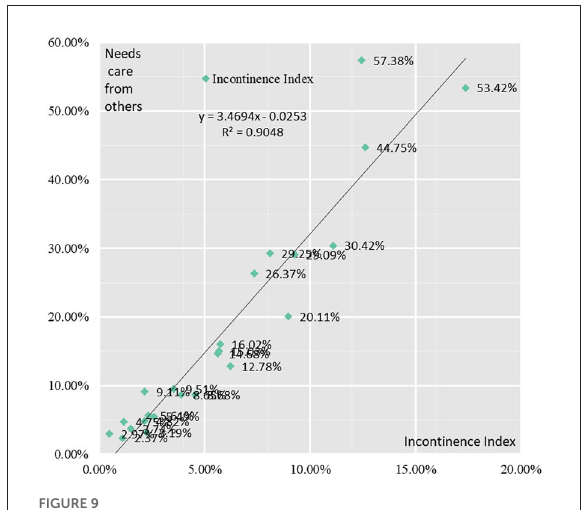
FIGURE9 Correlation analysis between healthcare needs of elderly people and incontinence.